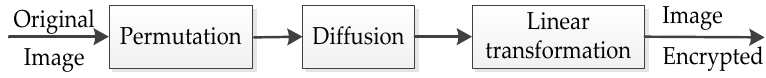
Figure 1. The flow diagram of the 1D chaotic image encryption.